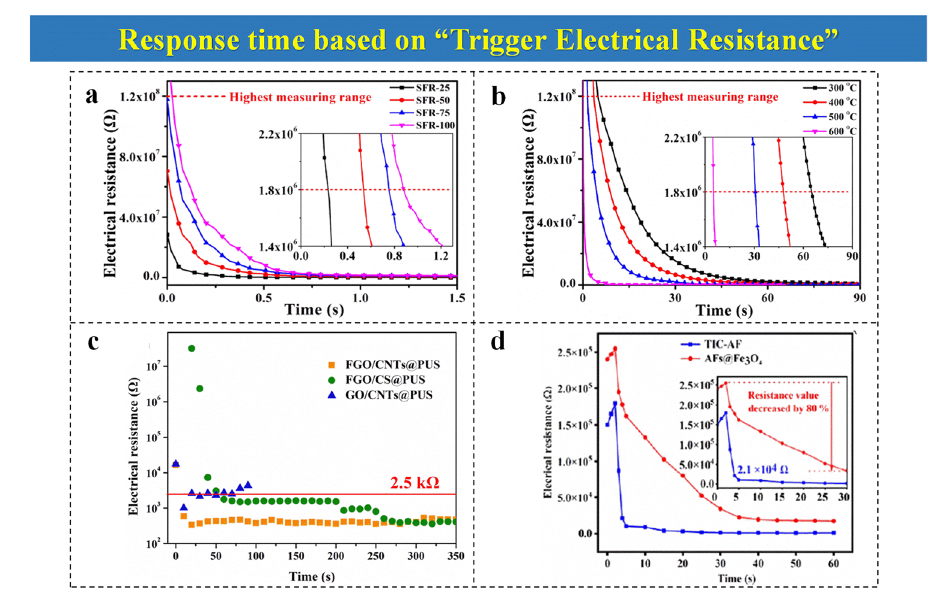
Fig. 2 A sandwich‑like EFWS: a temperature‑responsive resistance change curves of different sandwich‑like flame‑retardant (SFR) nano‑coat‑ ing during the whole fire‑warning process. b Temperature‑responsive resistance curves of SFR‑100 nanosheets at different test temperatures treatment. Reproduced with permission from Ref. [56]. Copyright 2020 Elsevier. GO‑based PU foam fire‑warning system: c electrical resistance curves of modified PU foam. Reproduced with permission from Ref. [59]. Copyright 2021 Elsevier. d Ultralight fire alarm e‑textile system: elec‑ trical resistance curves of AF@Fe 3 O 4 and thermal‑induced conductive aerogel fiber (TIC‑AFs) during fire‑warning process. Reproduced with permission from Ref. [54]. Copyright 2022 American Chemistry